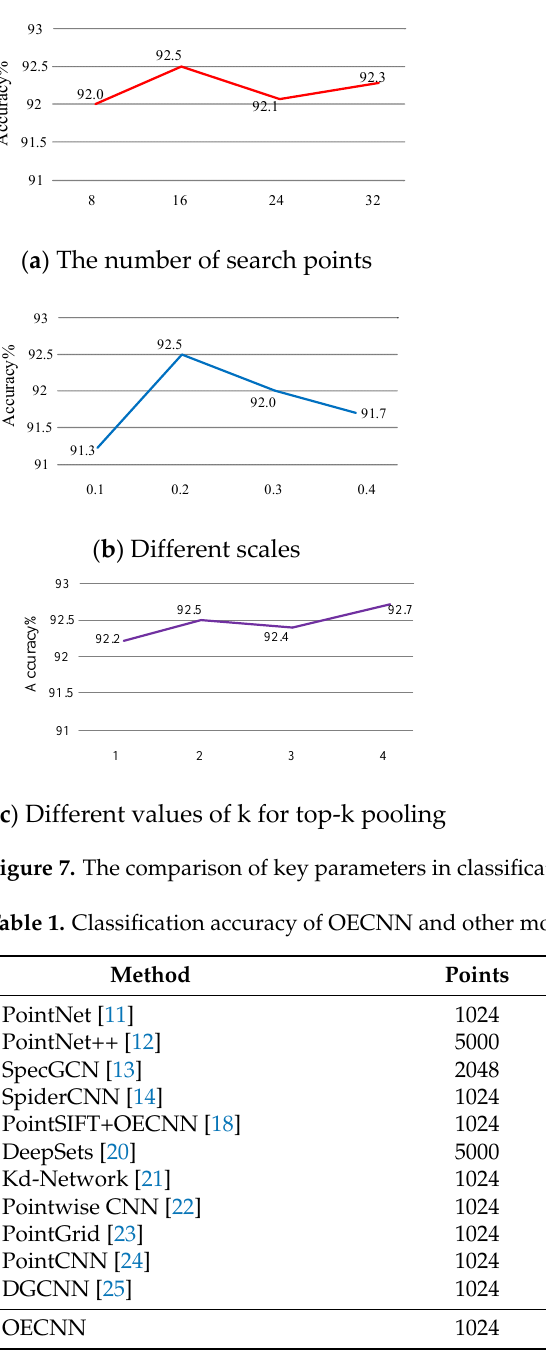
Figure 7. The comparison of key parameters in classification.